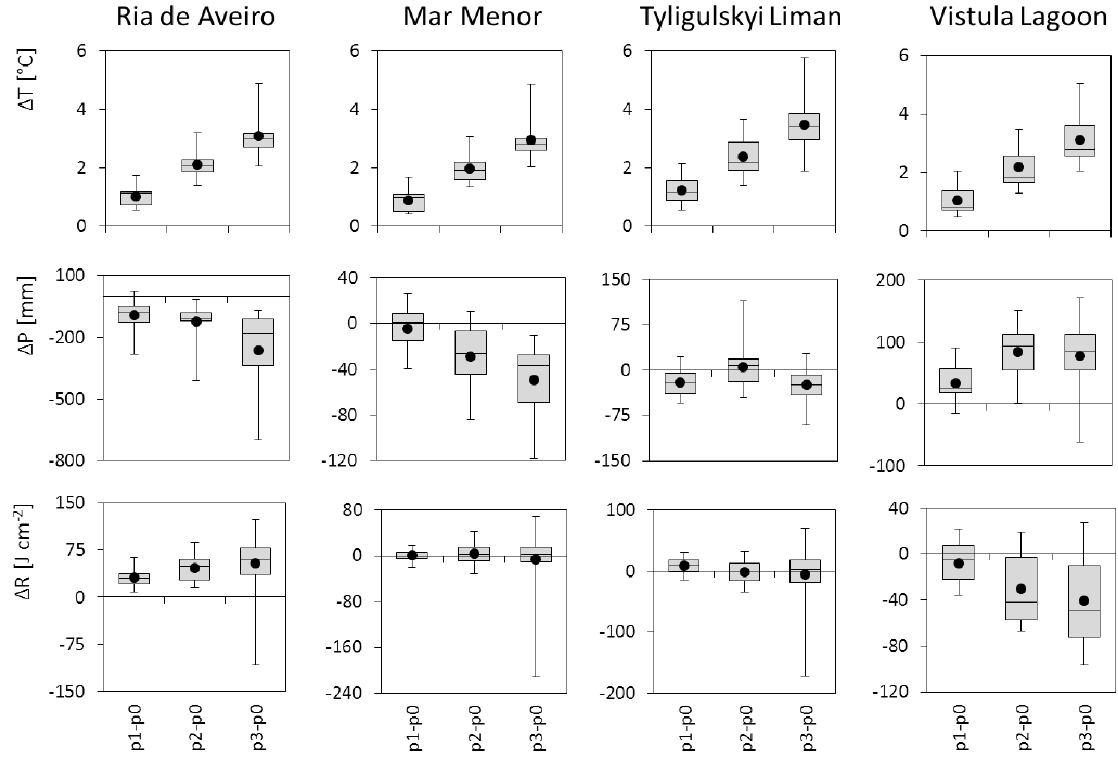
Figure 3. Ranges of climate change signals for 15 ENSEMBLES scenarios calculated as differences in the long-term average annual air temperature ( T ), precipitation ( P ) and solar radiation ( R ) between three future periods (p1, p2, p3) and the reference period (p0). The box plots visualize min/max (error bars), 25/75-percentiles (grey boxes), median (line) and average (dots)